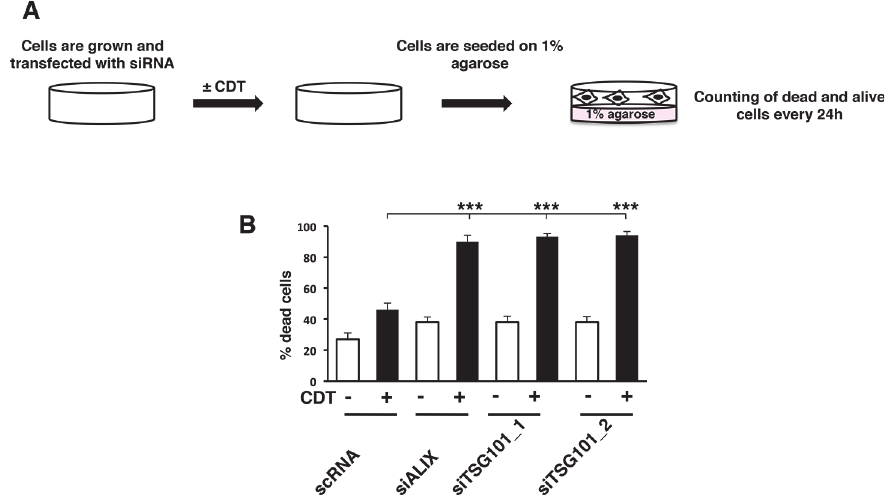
Fig 8. Integrin β 1 signaling via the ESCRT proteins TSG101 and ALIX is required to promote anchorage independent cell survival. A. Scheme of the anchorage-independent cell survival assay. HeLa cells, transfected with the non-silencing siRNA (scRNA), the ALIX or TSG101 specific siRNAs (siALIX and siTSG101), were left untreated or intoxicated with CDT (1 μ g/mL) for 6h. Cells were detached with 2.5 mM EDTA in PBS, and seeded on 12 well plate pre-coated with 1% agarose in complete medium to prevent adhesion. Cell viability was assessed by Trypan Blue exclusion every 24h. B. Quantification of dead cells 96h after seeding on plate pre-coated with 1% agarose. The data are presented as the mean ± SEM of three independent experiments. Statistical analysis was performed using the Student t-test. *** p value < 0.001.